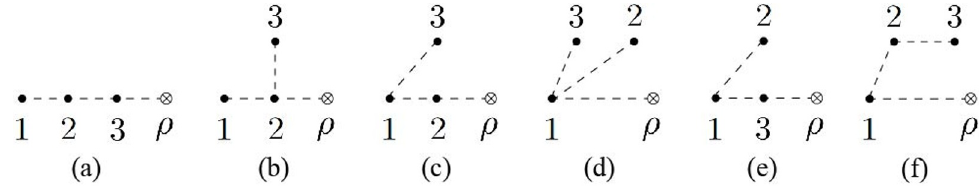
Figure 15 . Graphs without distinguishing line styles. In each graph, the dashed lines between nodes only reflect the relative orders between nodes but do not involve any kinematic